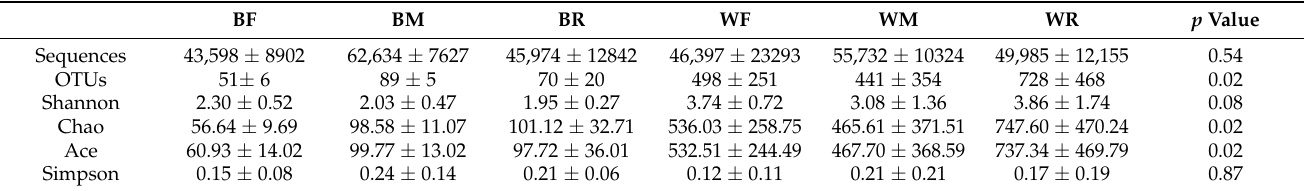
Table 1. Sequences, OTUs and alpha-diversity indices of gut microbiota of cultivated and wild Mastacembelus armatus . BF: foregut of cultivated individual; BM: midgut of cultivated individual; BR: reargut of cultivated individual; WF: foregut of wild individual; WM: midgut of wild individual; WR: reargut of wild individual.